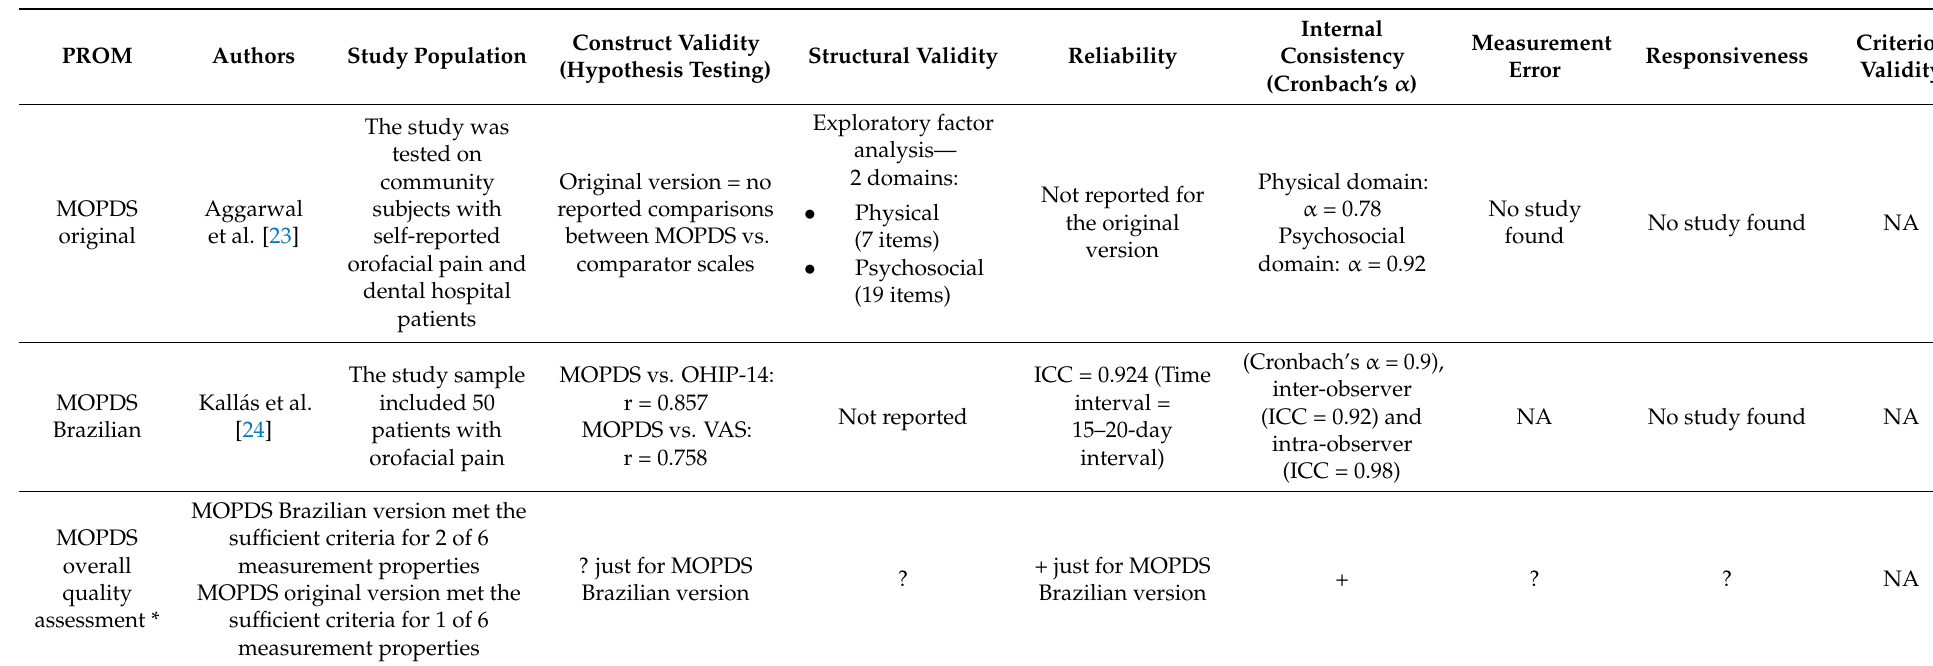
Table 4. Summary of the measurement properties of the Manchester Orofacial Pain Disability Scale (MOPDS)